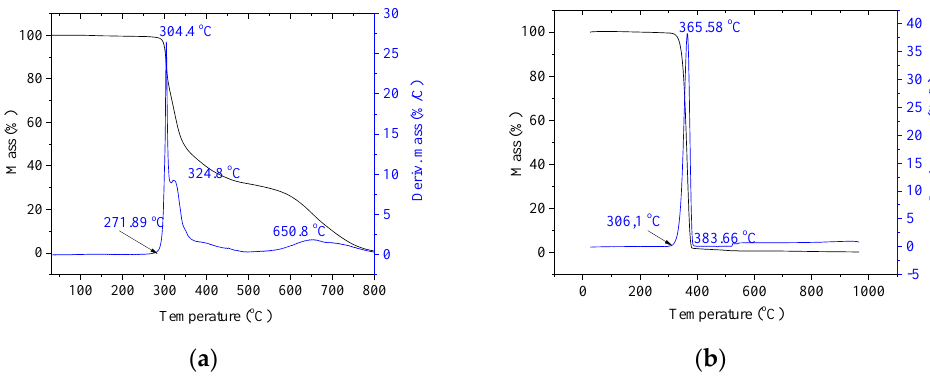
Figure 1. Thermogravimetric curves (TG/DTG) for ( a ) riboflavin ( b ) neat PLA,